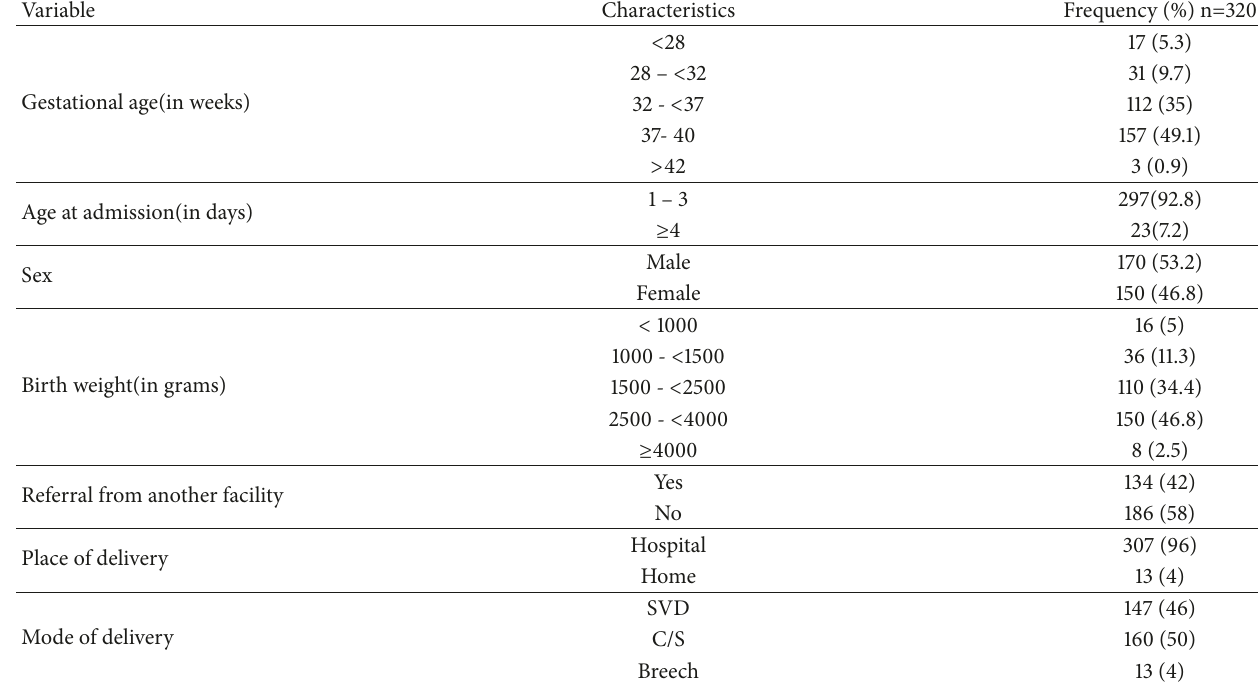
Table 1: Socio-demographic characteristics of participants.